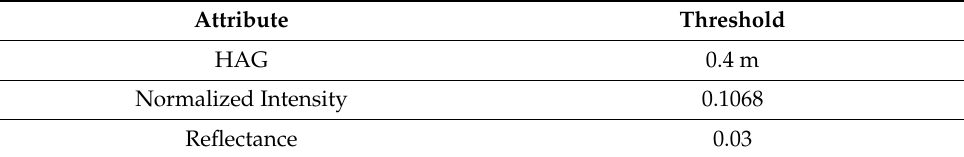
Figure 10. ( a ) Segment of Road under foliage ( b ) Zoomed-in image. ( c ) Foliage covering a section of the road. Table 3. Typical Threshold Values for Filter